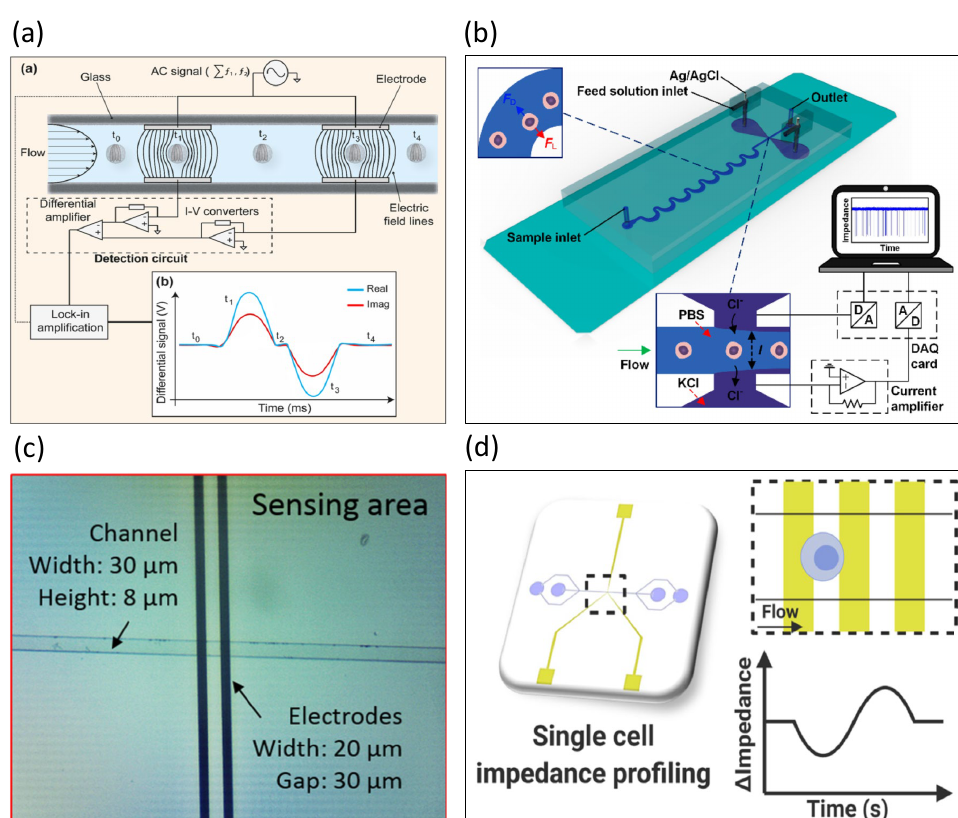
Figure 7. Dynamic cell analyzed by microfluidic impedance cytometry. ( a ) A model of the impedance flow cytometer was established to distinguish Cryptosporidium parvum, Cryptosporidium muris, and Giardia lamblia in minutes. Reproduced with permission from [104]. Copyright Scientific Reports 2017. ( b ) A microfluidic impedance cytometer integrating inertial focusing and liquid